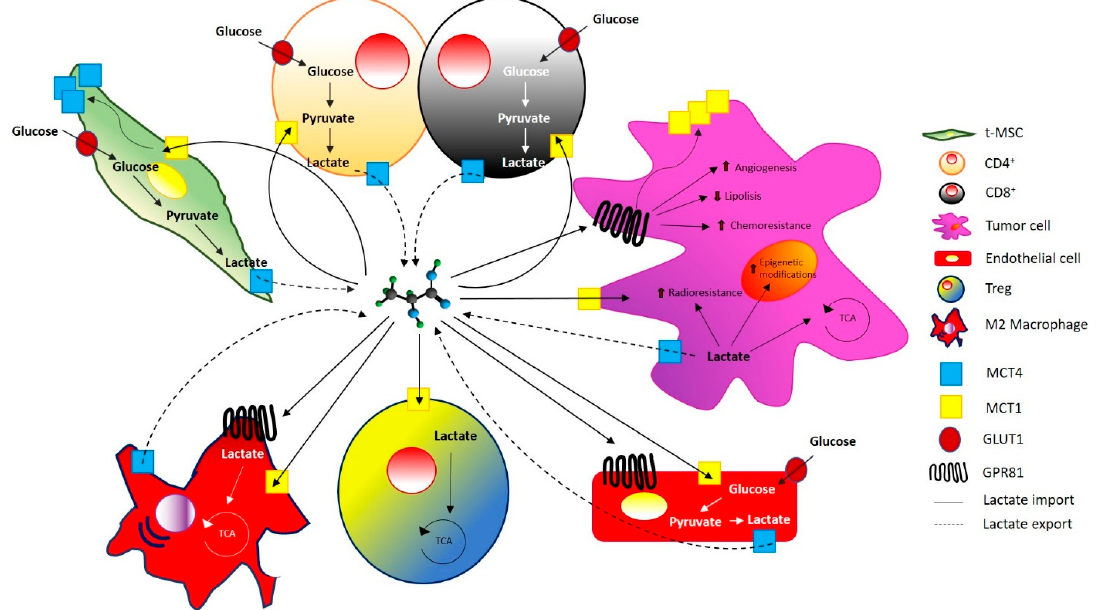
Figure 3. Lactate trafficking in tumor and stromal cells. Lactate shuttles through monocarboxylate transporter (MCT) present both in tumor and stromal cells. GPR81, a specific receptor for lactate is expressed on stromal cells and on different cancer cells, mediating chemoresistance, angiogenesis, decreasing lipolysis and up-regulating MCT1 expression.